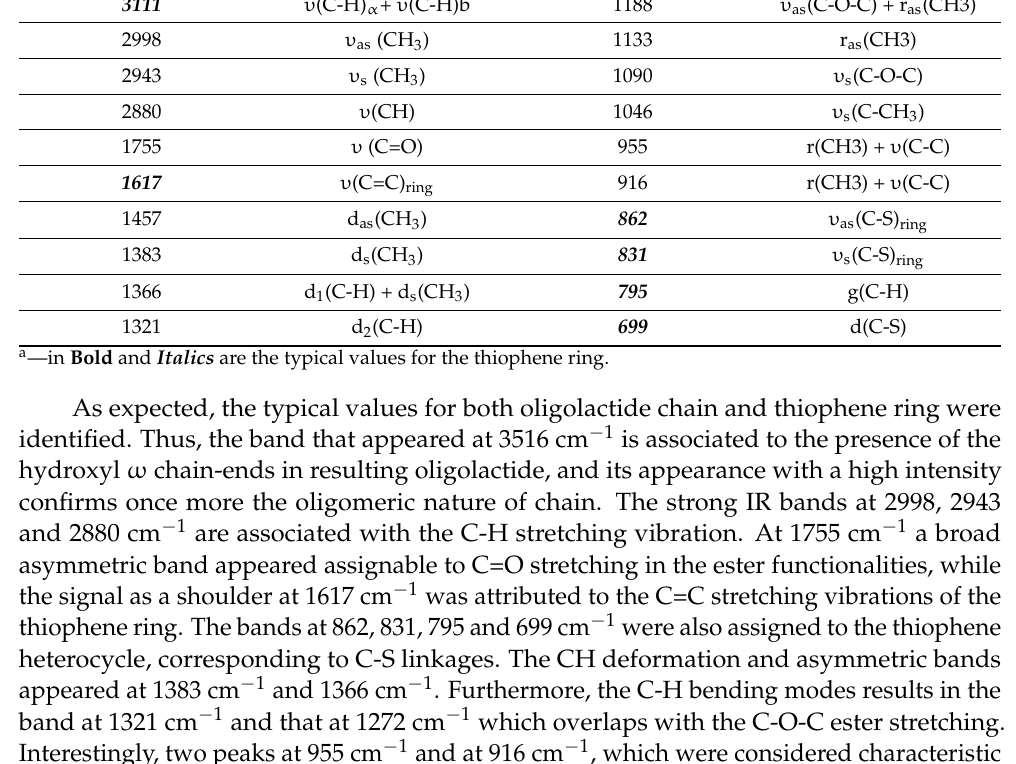
Table 1. Data from the Th-PDLLA FTIR spectrum (Figure S2) a . Band Position (cm − 1 ) Assignment Band Position (cm − 1 ) Assignment 3516 υ (OH) 1272 d(C-H) + υ (C-O-C) 3111 υ (C-H) α + υ (C-H)b 1188 υ as (C-O-C) + r as (CH3) 2998 υ as (CH 3 ) 1133 r as (CH3) 2943 υ s (CH 3 ) 1090 υ s (C-O-C) 2880 υ (CH) 1046 υ s (C-CH 3 ) 1755 υ (C=O) 955 r(CH3) + υ (C-C) 1617 υ (C=C) ring 916 r(CH3) + υ (C-C) 1457 d as (CH 3 ) 862 1383